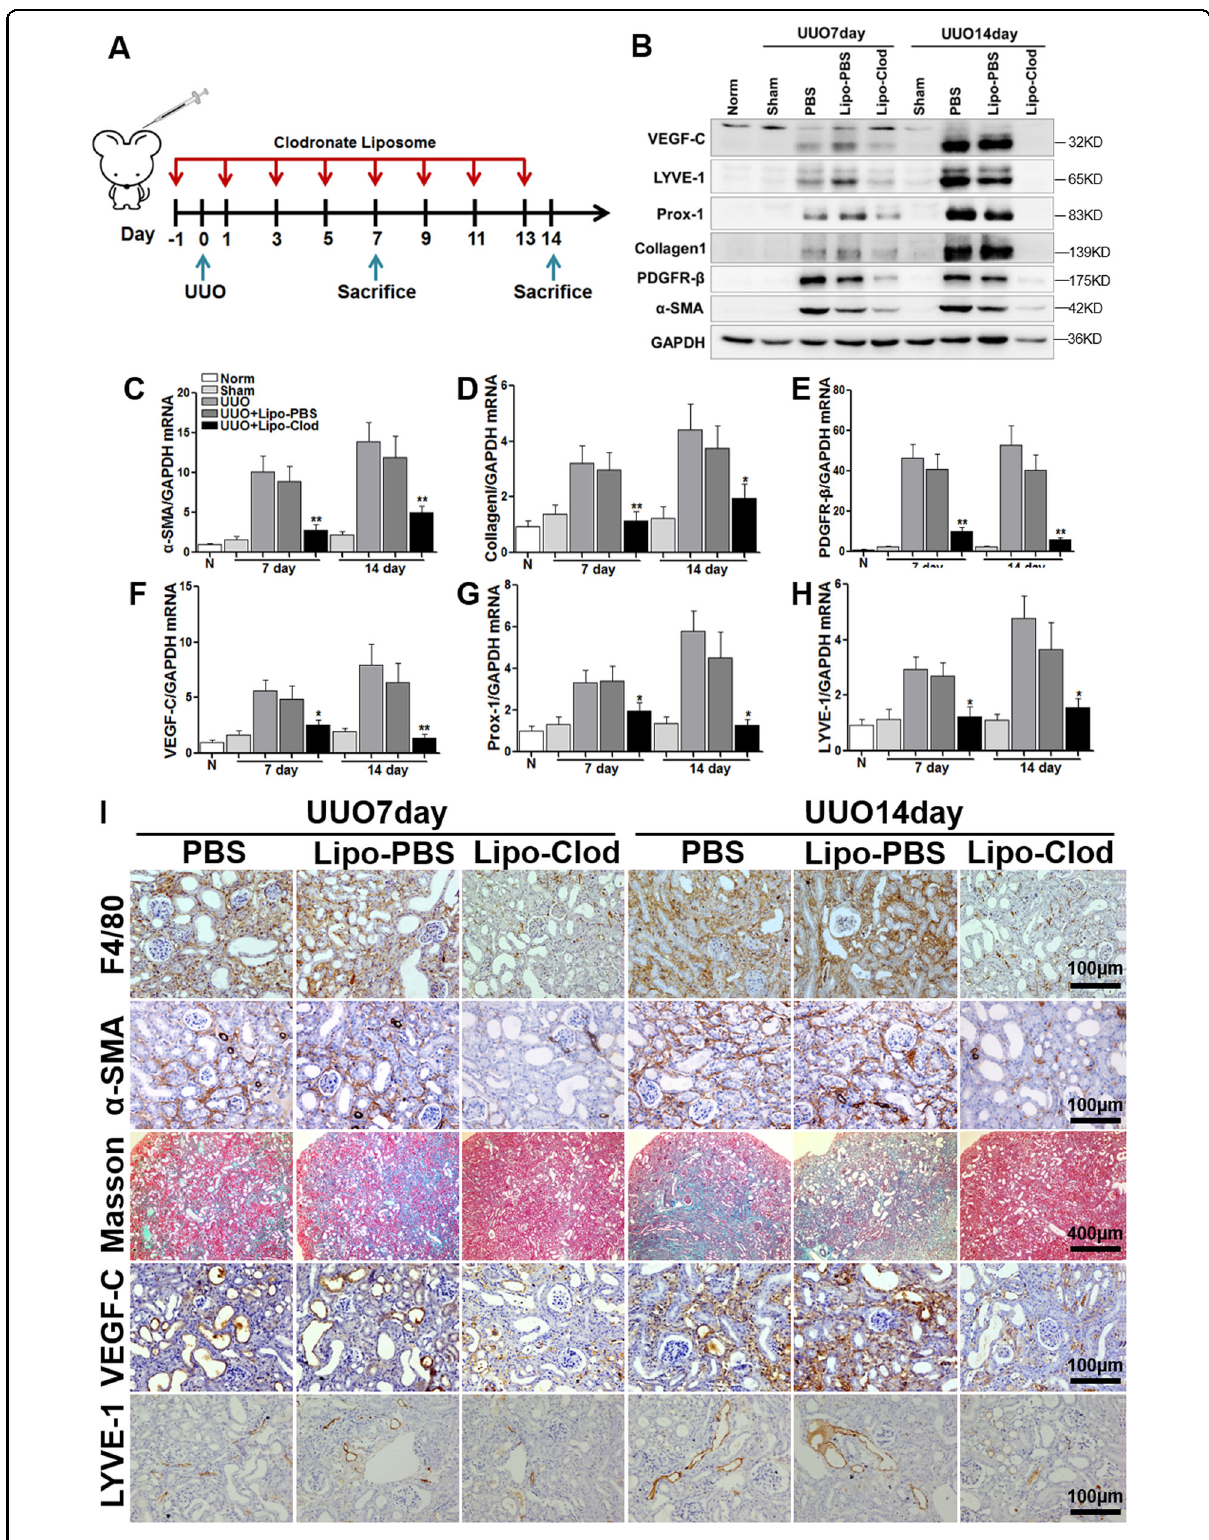
Fig. 2 (See legend on next